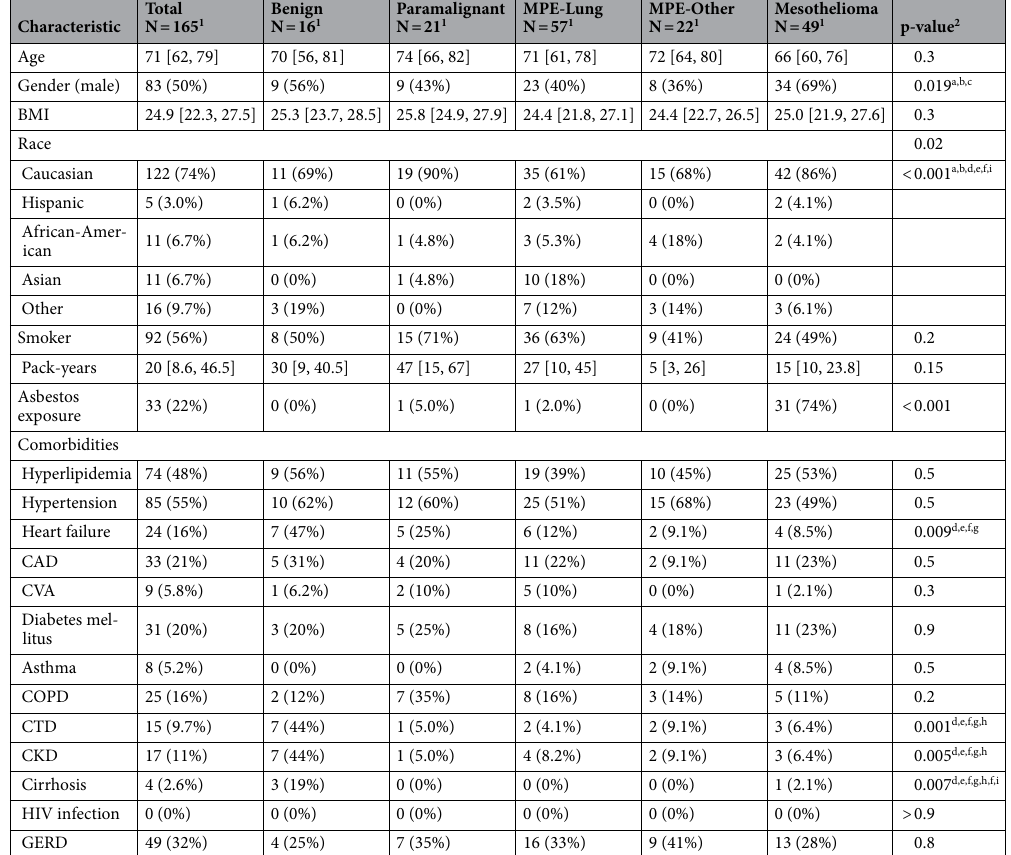
Table 1. Subject demographics. CAD coronary artery disease, CVA cerebrovascular accident, COPD chronic obstructive pulmonary disease, CTD connective tissue disease, CKD chronic kidney disease, HIV